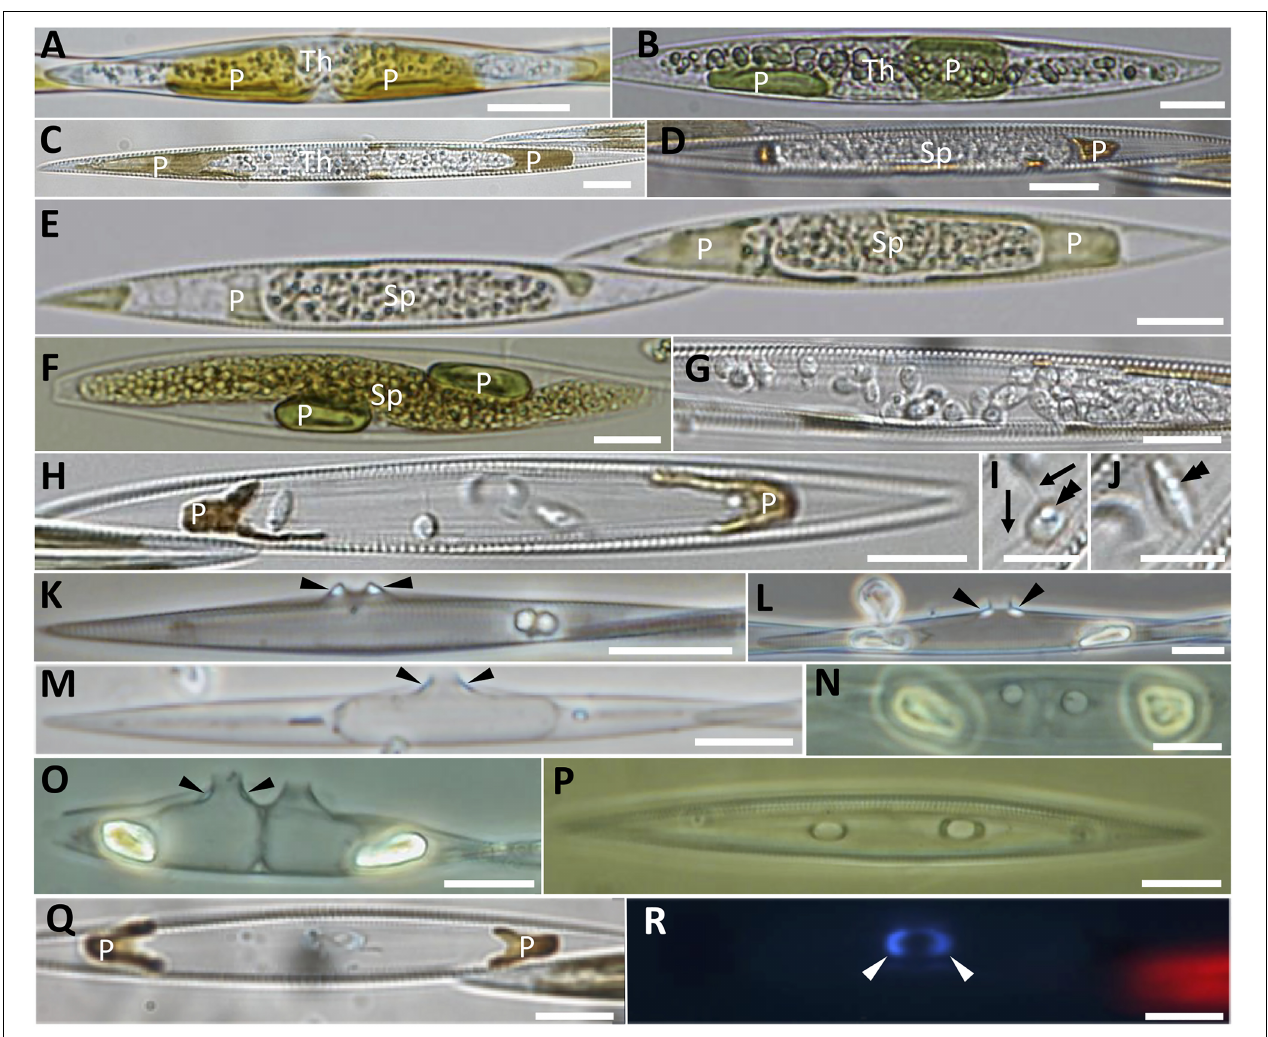
FIGURE 1 | Morphological characterisation of the novel oomycete parasitoids of Pseudo-nitzschia described in this study. (A–C) Unwalled, increasingly granular thalli developing in Pseudo-nitzschia australis (A,B) and Pseudo-nitzschia cf. pungens/multiseries cells (C) ; thalli are progressively pushing apart the degraded, yet still pigmented plastids. (D–F) Holocarpic syncytia maturing into sporangia, in Pseudo-nitzschia cf. pungens/multiseries (D,E) and Pseudo-nitzschia australis (F) . (G–J) Zoospore release in Pseudo-nitzschia cf. pungens/multiseries . Zoospores bear two flagella (arrows in I ), a single refractive globule (double arrowheads in I and J ) and their shape varies from almost spherical (I) to oblong (J) . (K–R) Empty sporangia. Arrowheads point to thickenings in the discharge tube. (K) Pseudo-nitzschia pungens/multiseries , valve view. (L) Pseudo-nitzschia australis , valve view. (M) Empty sporangium within Pseudo-nitzschia fraudulenta, valve view. (N–P) Two empty sporangia within a Pseudo-nitzschia fraudulenta frustule, girdle view (N) and valve view (O) , and Pseudo-nitzschia pungens/multiseries, girdle view (P) . (Q,R) Pseudo-nitzschia cf. pungens/multiseries , girdle view, under DIC (Q) and epifluorescence microscopy ( R , Calcofluor-White staining), to highlight the thickening of the discharge tube. Scale bars = 10 µ m except in I , J (5 µ m). Samples in (B,E,F) were Lugol’s iodine fixed. (B) Refers to the sequenced cell P. australis parasitoid 10-044. Th, thallus; Sp, sporangium; P ,